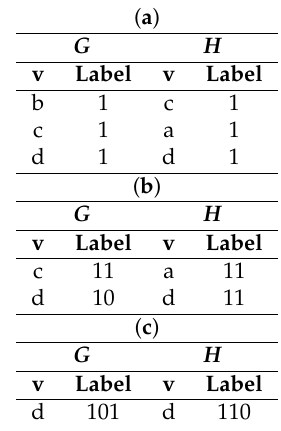
Table 1. Labels on the non-mapped vertices of G and H with mapping: ( a ) M = { a , b } , ( b ) M = { ab , bc } and ( c ) M = { abc , bca } .